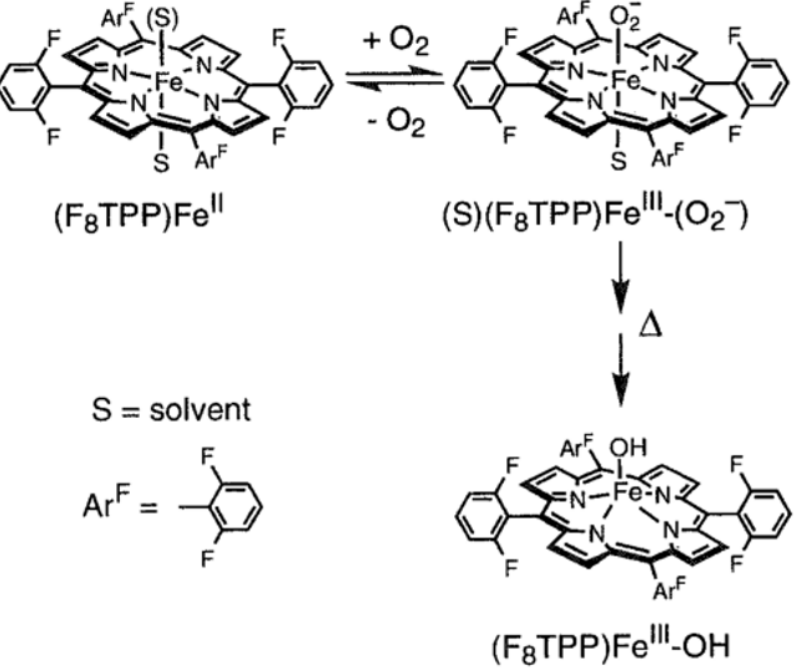
Figure 7. Formation of [(THF)(F 8 TPP)Fe III (O 2 •− )] and its thermal decay to [(F 8 TPP)Fe III (OH)]. Reprinted with permission from Ref. [100]. Copyright 2001, American Chemical Society.